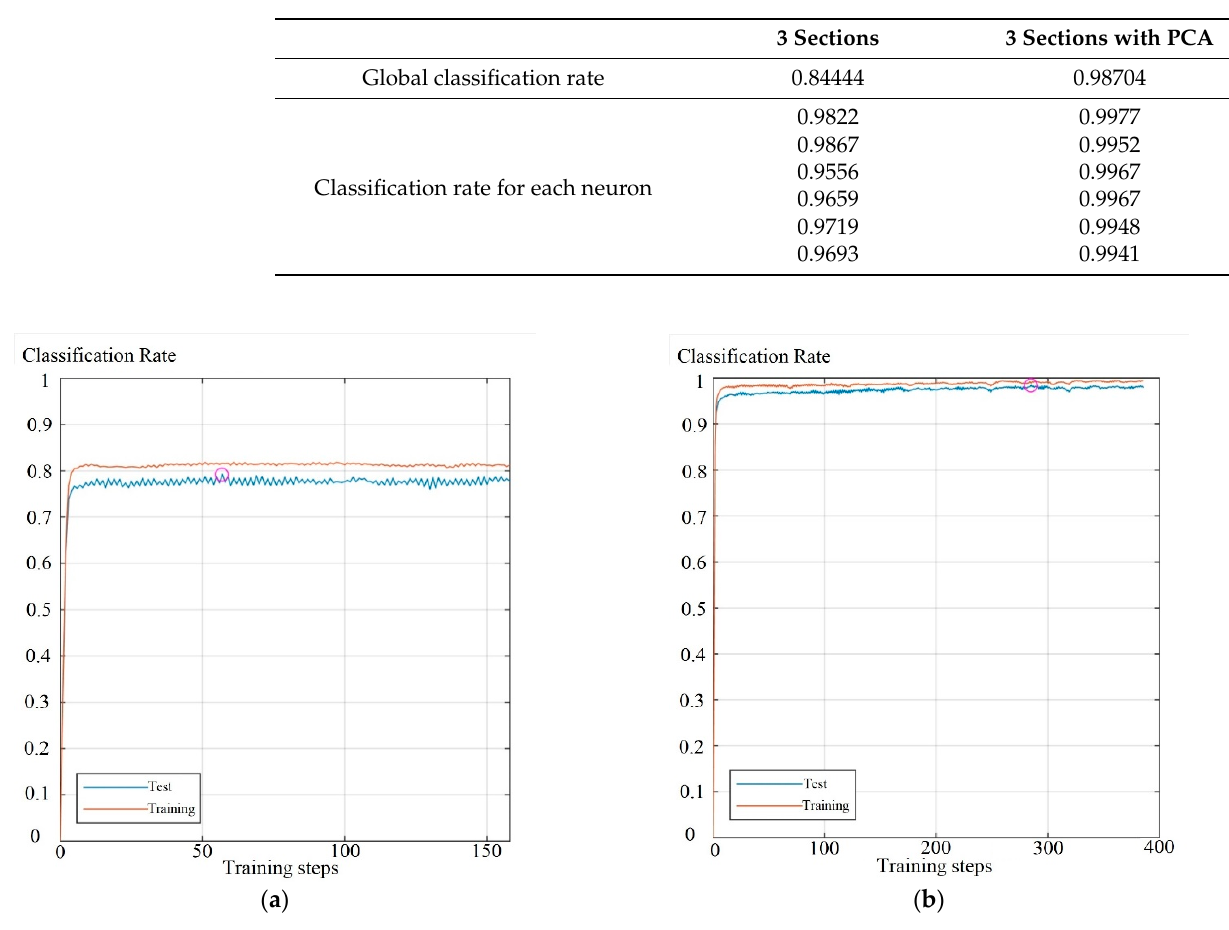
Table 7. Summary of the classification results obtained for three cable sections.